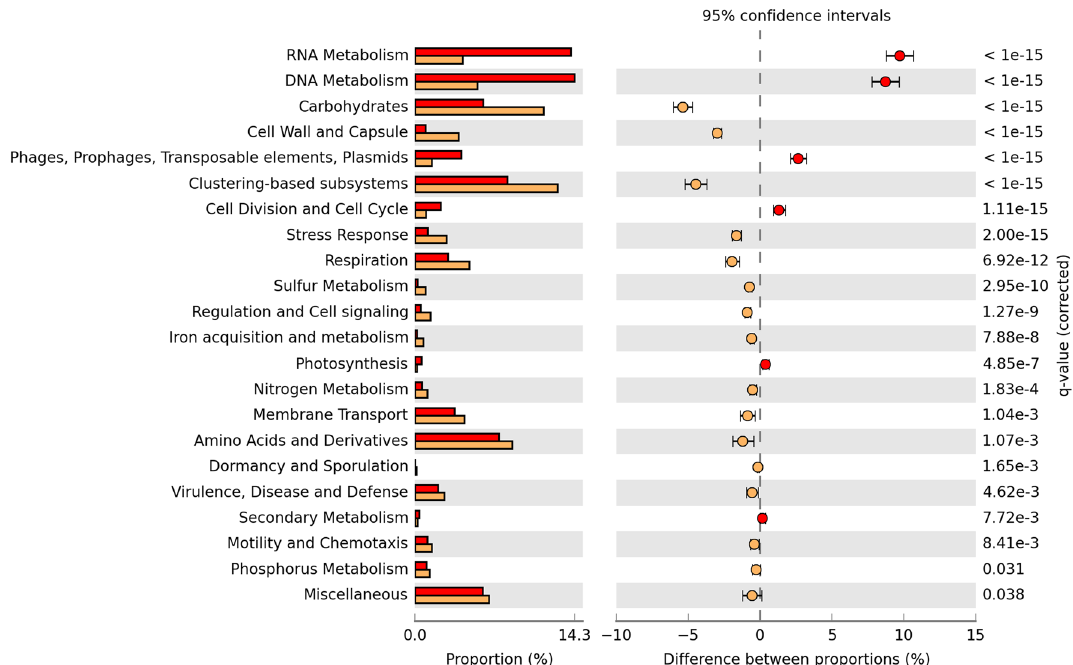
Figure 4. Predicted functional profiles derived from the Diamante Lake plasmidome (red bars) and the Puquio de Campo Naranja plasmidome (orange bars). Percent SEED categorizable protein-encoding genes and pairwise proportional differences calculated using STAMP. Fisher’s exact test was used and corrected P-values were calculated using Storey’s FDR. Only the statistically significant SEED subsystems are shown (q < 0.05).